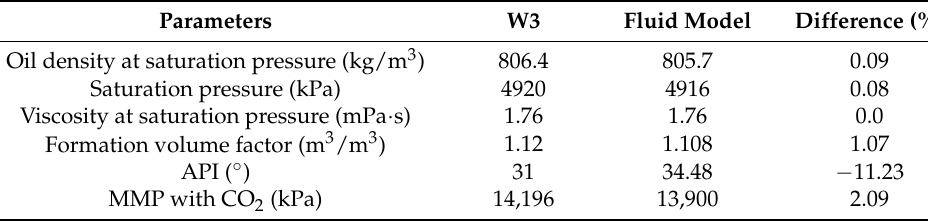
Table 3. Comparison of the data for Weyburn fluid and the fluid